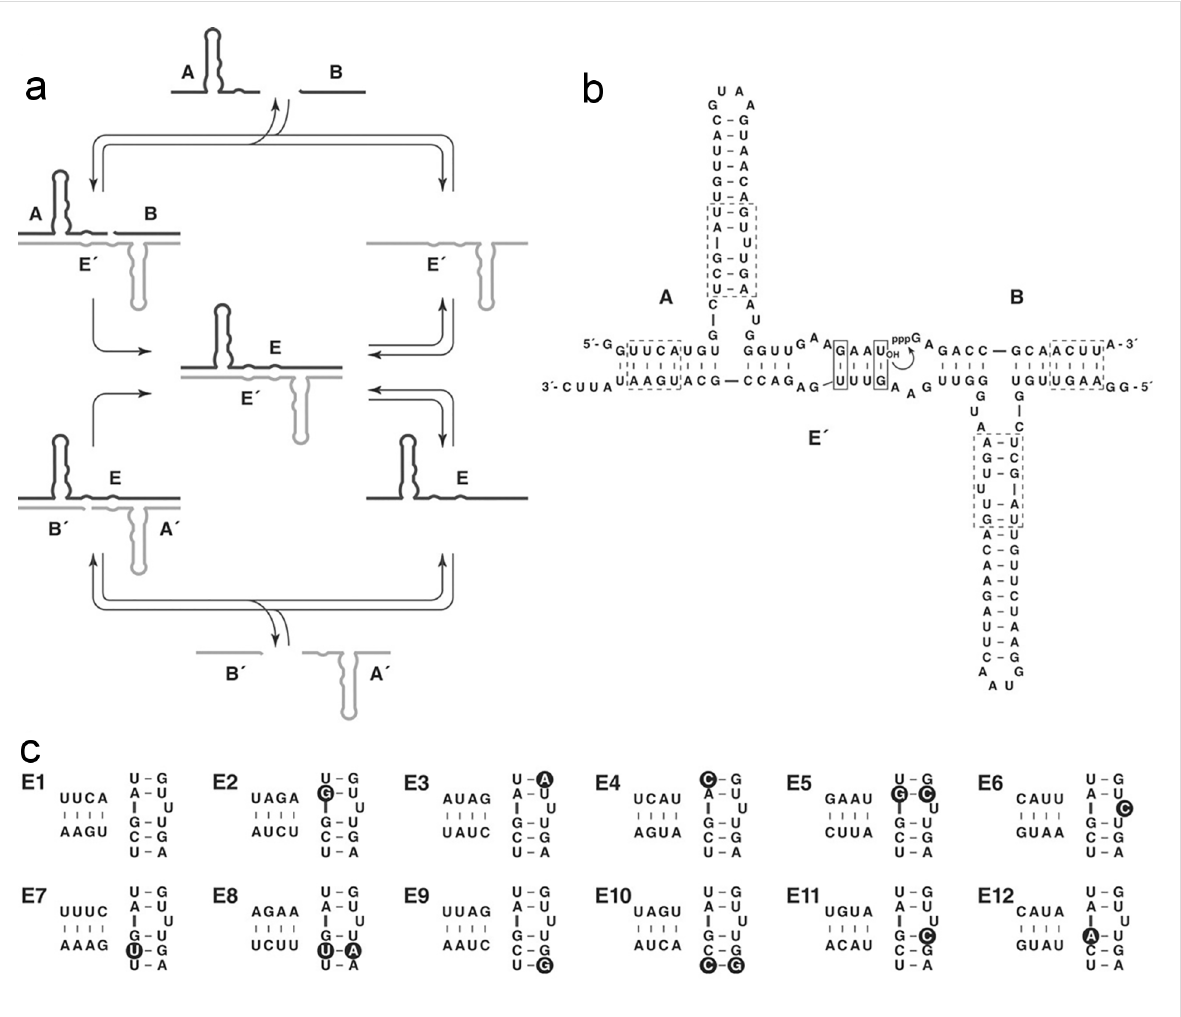
Figure 8: (a) Cross-catalyzed replication of template molecules E and E’ from their building blocks A ( ’ ) and B ( ’ ) . (b) Secondary structure of the tem- plate duplex. The curved arrow denotes the site of ligation of the building blocks, the dashed boxes include the sequences to be mutated and the solid lines indicate the sites of the G ∙ U base pairs inducing the wobble that enhances catalytic activity. (c) The altered sequences of the 12 different tem- plate molecules, the E’ molecules have complementary sequences in the base pairing part (horizontal) and identical sequences in the catalytic part (vertical). Dark circles denote the differences relative to E1